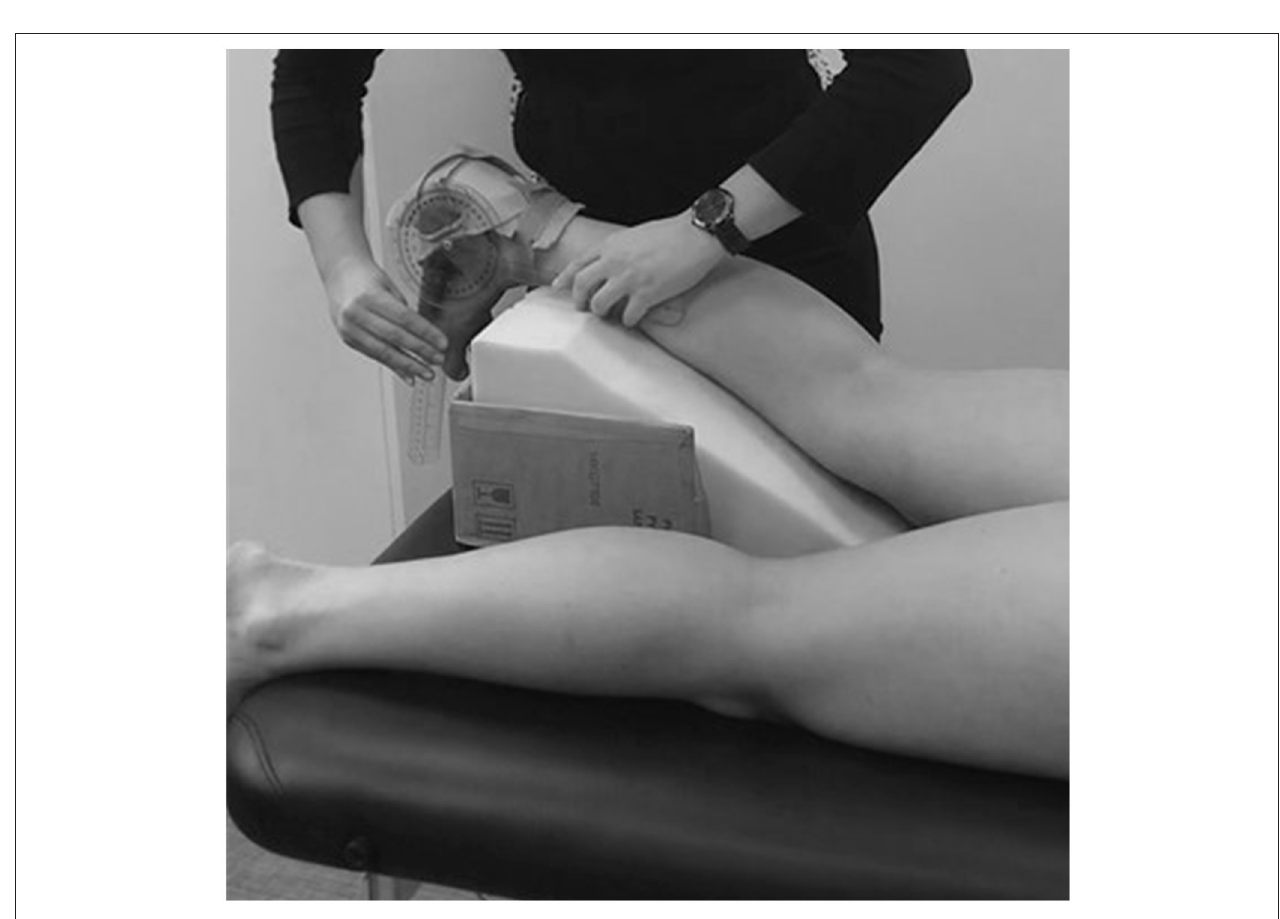
FIGURE 1 | Position of the lower limb during